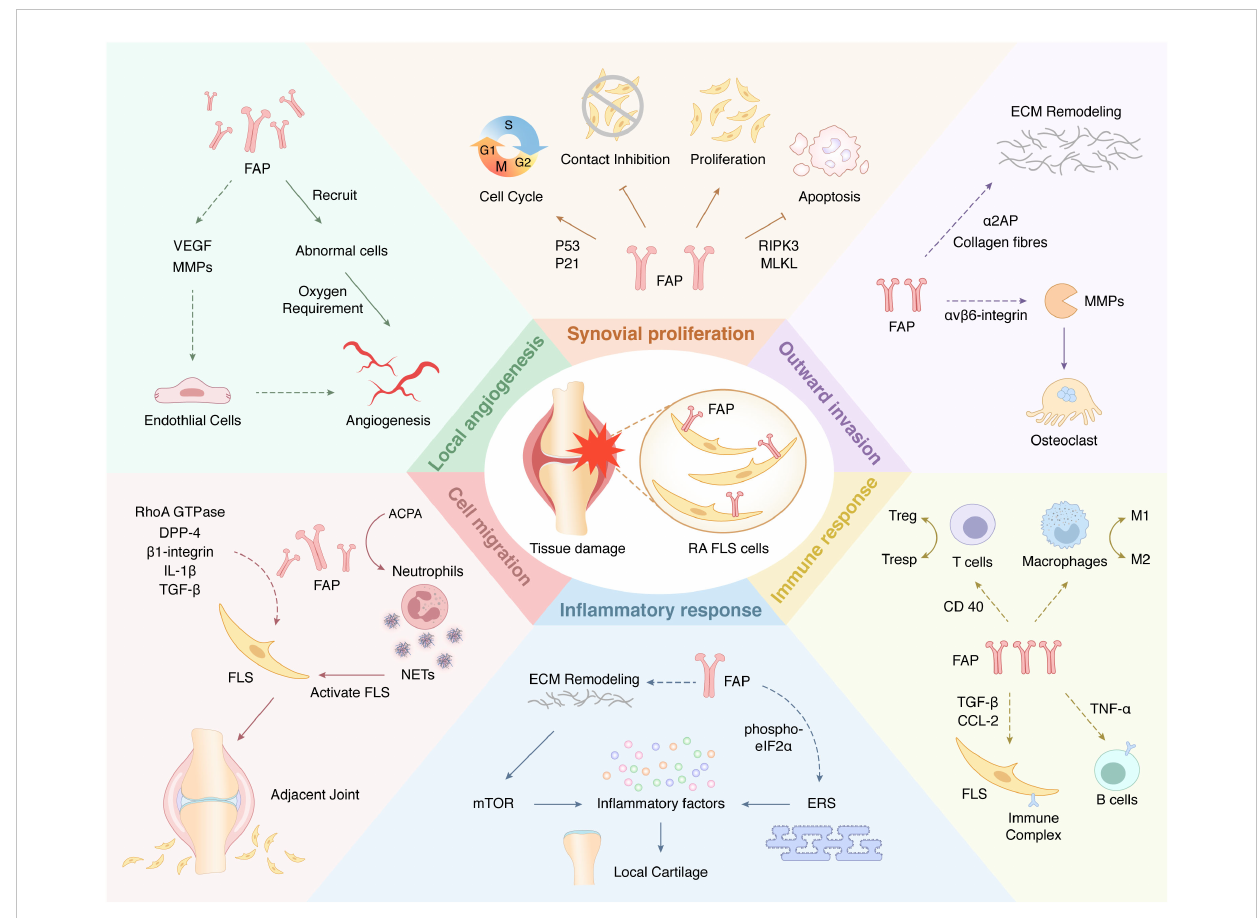
FIGURE 2 A Schematic view of cellular functions of FAP-mediated FLSs in RA. Arrows ( ↓ ) indicate positive impact, while inverted Ts ( ⊥ ) indicate negative impact. The dotted arrows ( — ) indicate studies that exist but have not yet been validated in the RA fi